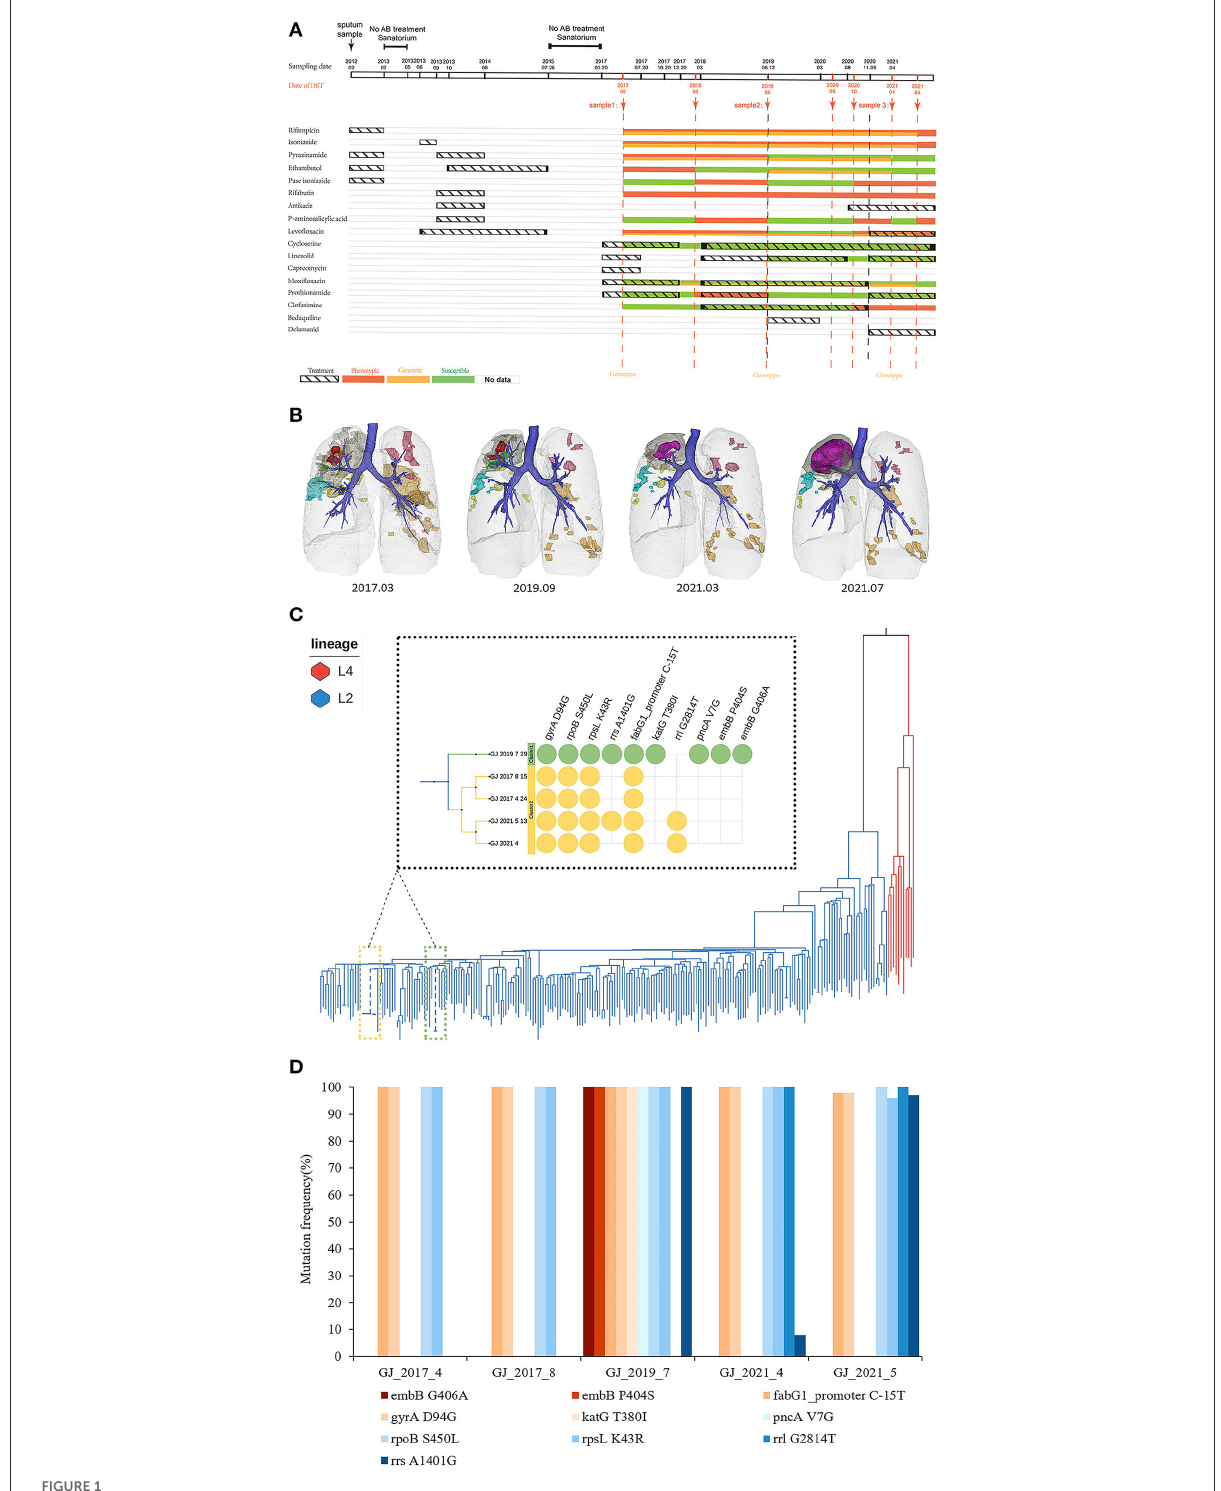
FIGURE1 Treatment history, CT images, phylogenetics and drug resistance profiles, and unfixed mutation subgroups of drug resistance genes. (A) Treatment History. Anti-tuberculosis drugs used in different periods. (B) Three-dimensional visualization of CT scans demonstrates the longitudinal anatomical change in lung lesions. Lesions in different lung lobes are shown in different colors, and the trachea (blue) and pulmonary contours (light gray) are shown as references. There were two independent cavities 1 (red) and 2 (green) in the right upper lobe parenchymal abnormality (dark gray) in March 2017, which appeared partial absorption in September 2019, and subsequently fused extensively and infiltrated outward (magenta) from March to July 2021. Such rapid deterioration resulted in the destruction of the right upper lung lobe. All other lung lobar lesions showed a benign response to treatment or remained relatively stable. Lesions of the right middle lobe (cyan), right